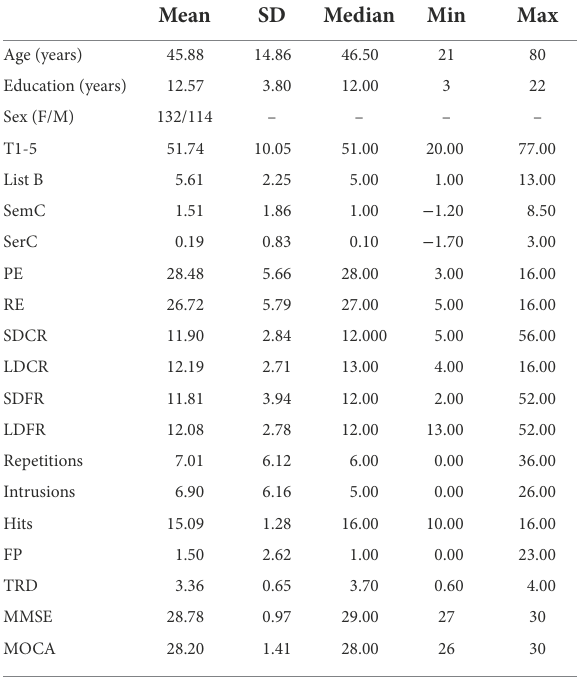
TABLE 1 Descriptive statistics of CVLT-II scores for all healthy